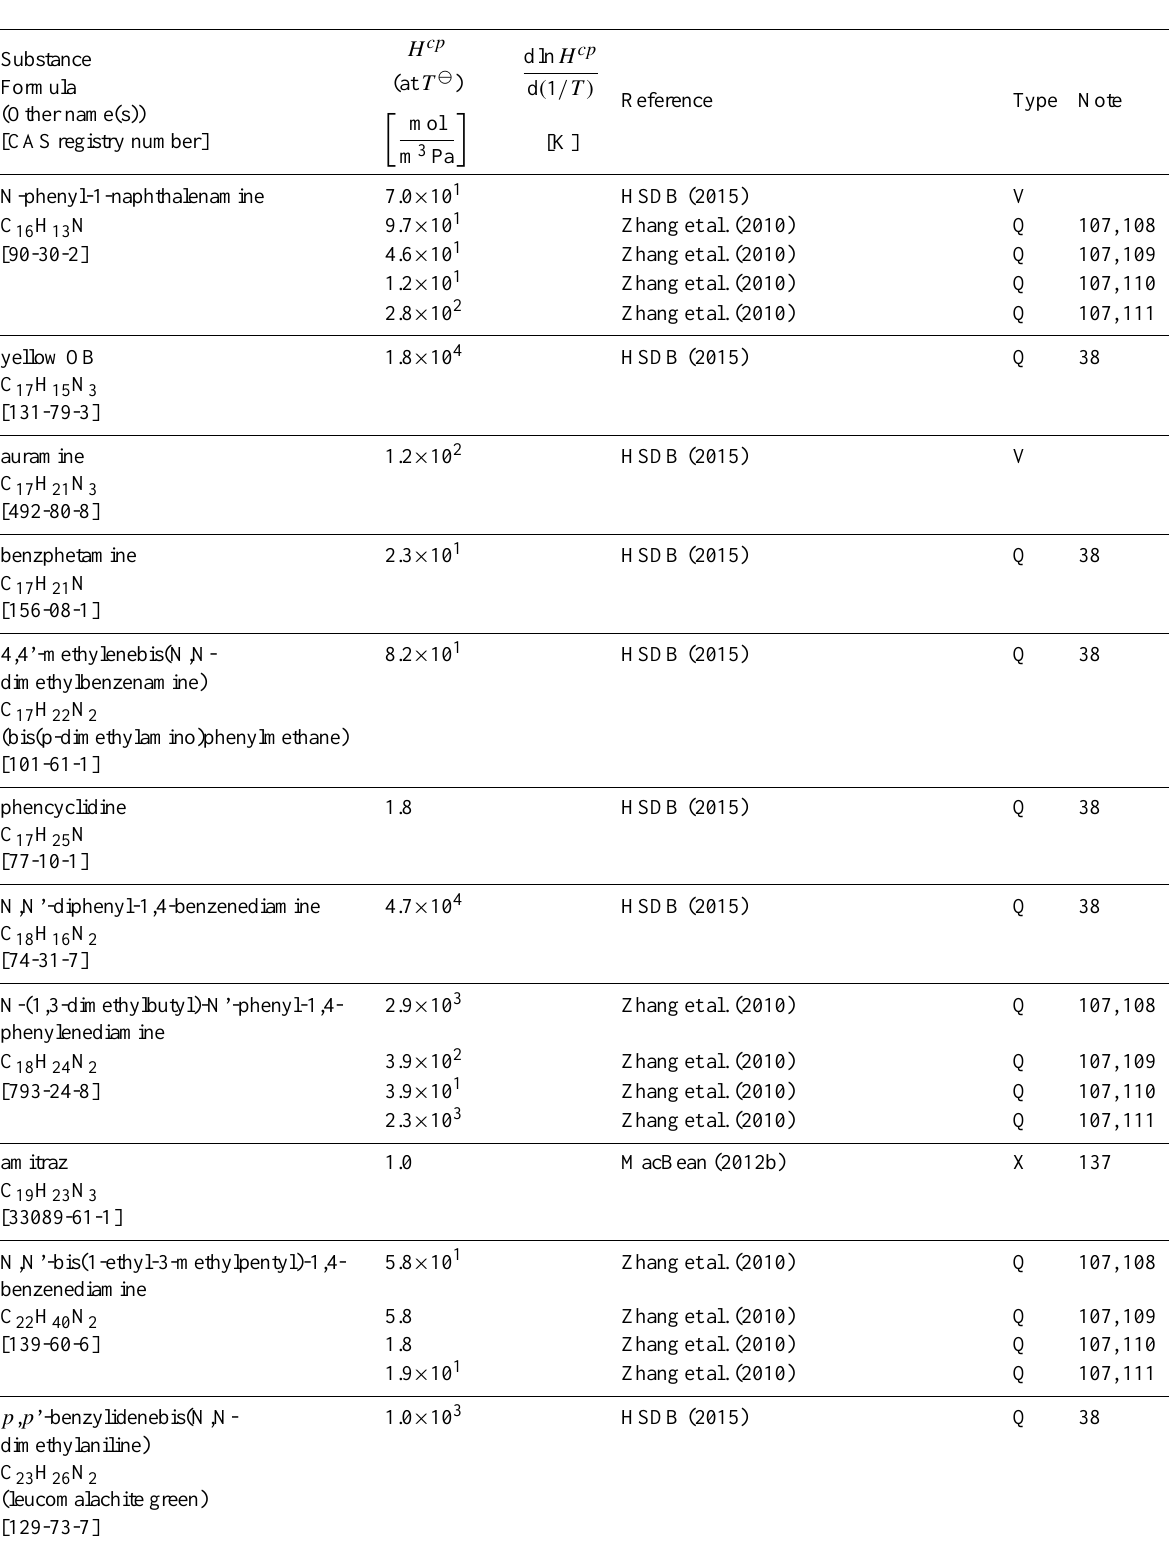
Table 6: Henry’s law constants for water as solvent